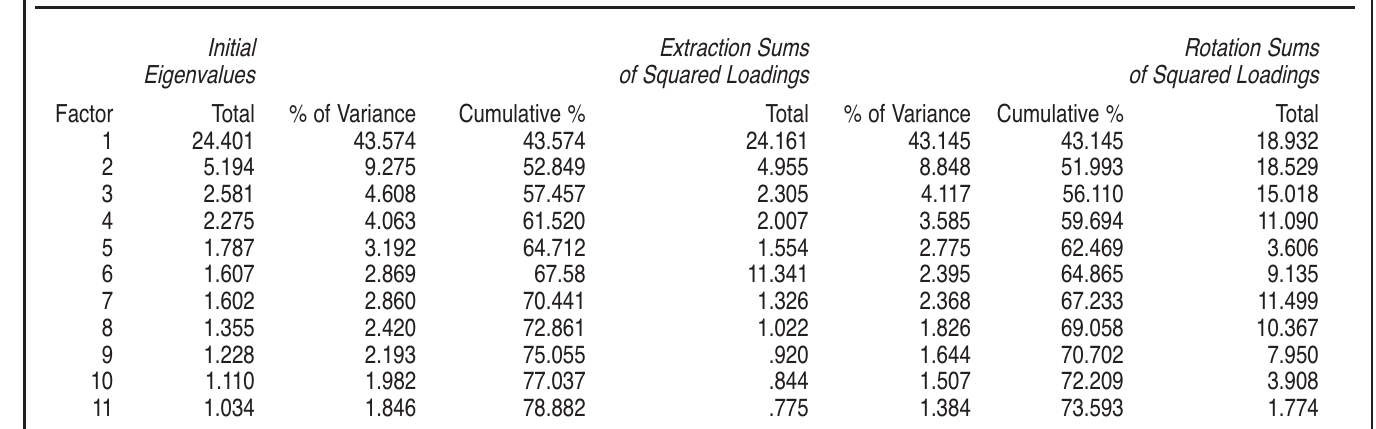
Table 1. Results of Factor